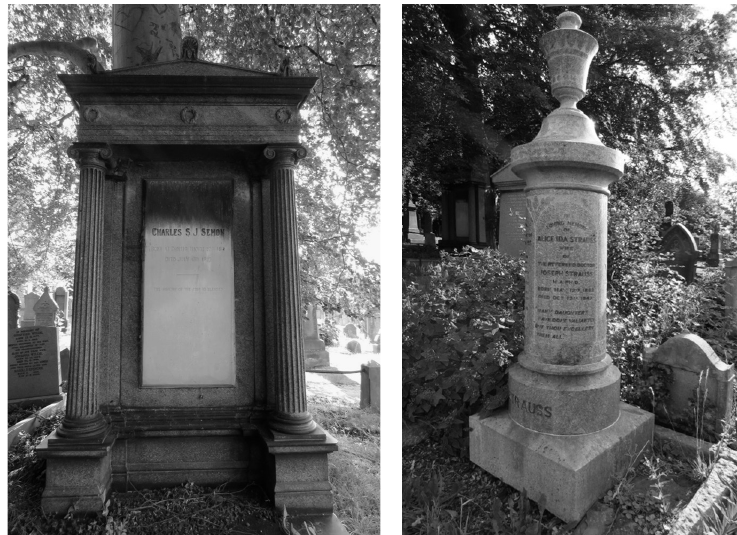
(right), Bradford Jewish Reform Cemetery. Photographs Grace